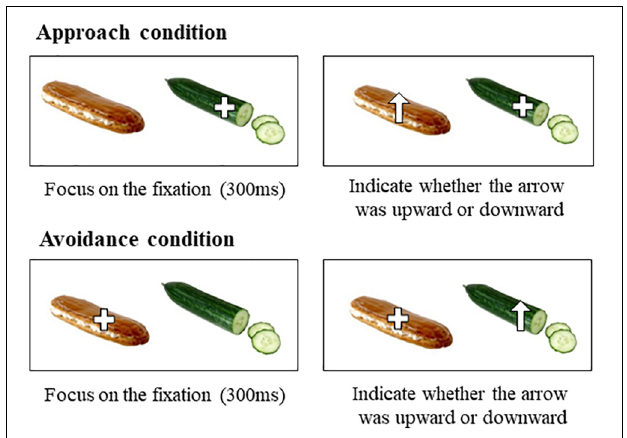
FIGURE 1 | Paradigm of the attention